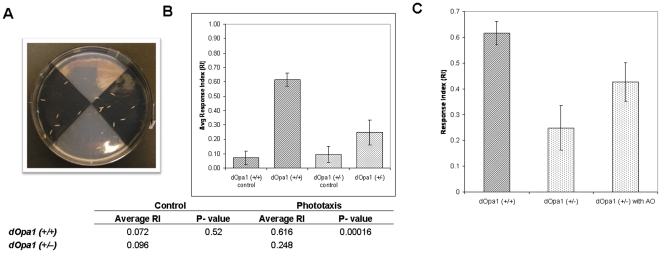
A. Larval phototaxis assay. A plastic petri plate was divided into four quadrants, two dark quadrants diametrically opposite to two clear quadrants. 1% agarose was used for the clear and 1% agarose containing 0.6% charcoal powder was used for the dark quadrants. 50 second instar larvae were placed at the center of the plate and were allowed to migrate for 3 minutes in complete darkness for the control, and in the presence of light by using a light box. The assay was repeated 3 times. Figure 3B. Larval Phototaxis Response Index. 50 second instars were used for each trial (total of 3 trials each). Wildtype dOpa1+/+ exhibited strong negative phototatic response in the presence of light (RI = 0.616). Heterozygous mutant dOpa1+/in3 showed little light response (RI = 0.248). Antioxidant treatment made no difference in wildtype dOpa1+/+ (RI = 0.667). Mutant dOpa1+/in3 treated with antioxidant exhibited a significantly stronger negative phototatic response to light (RI = 0.427).